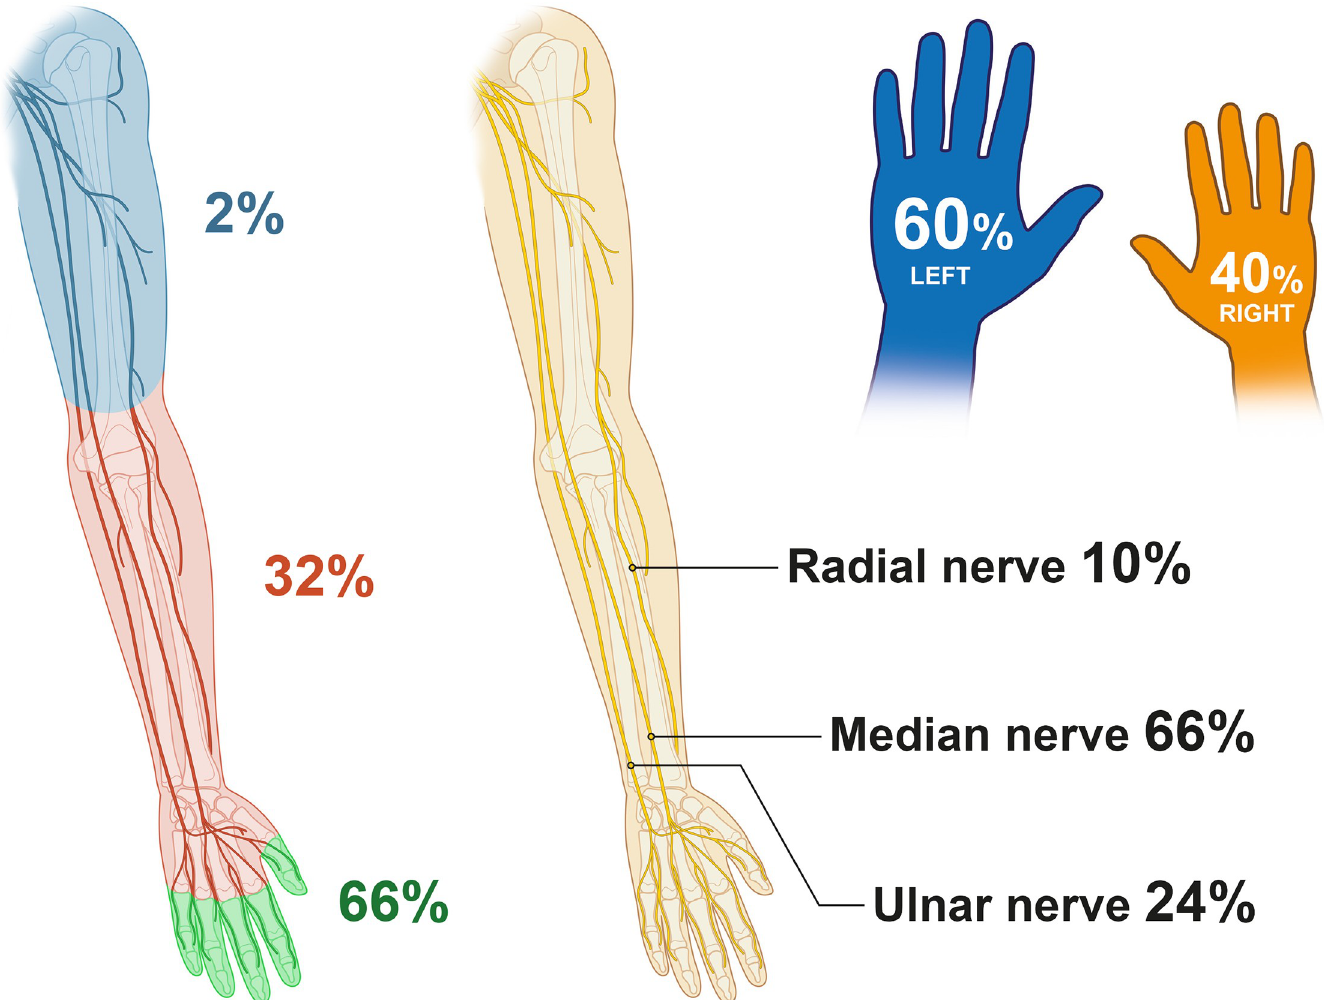
Fig 3. Characteristics of nerve injuries: Left : Shown is the level of nerve injury as percentage of all included nerve injurie in a selected collective of work-related nerve injuries. These demonstrate a mainly distal location of these nerve injuries. Middle : Shown is the proportion per nerve of all included single nerve injuries, with a majority of median nerve lesions. See Table 1 for detailed information on injured nerve in relation to injury location. Right : The majority of injuries was to the left hand.